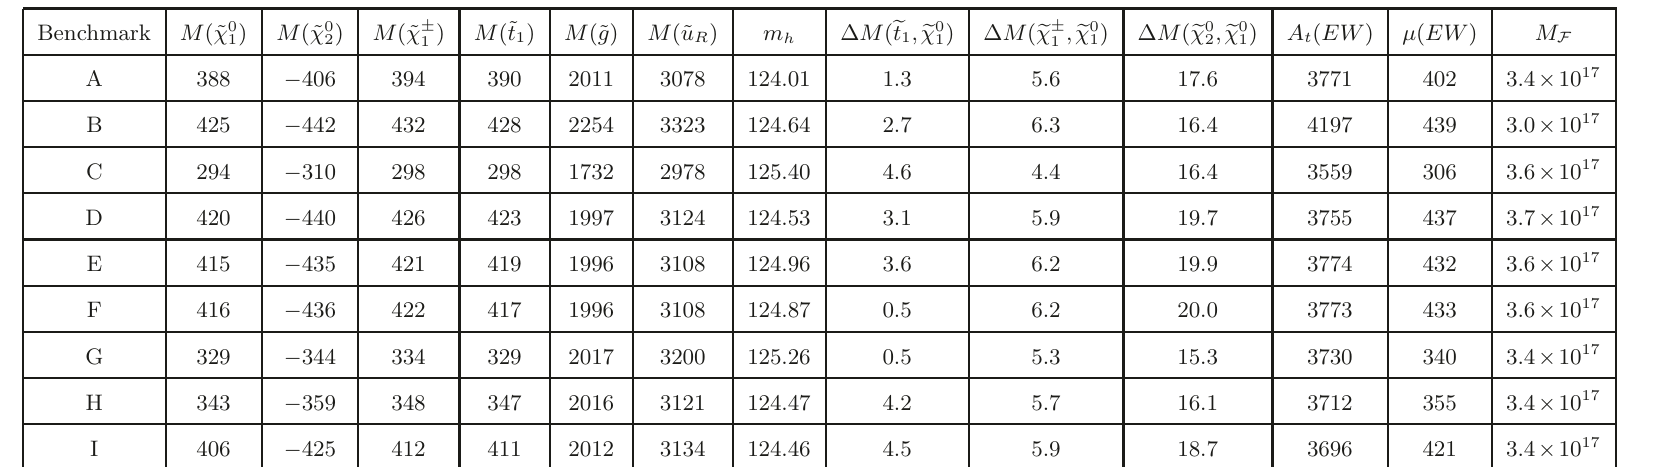
Table 2 . Relevant SUSY spectrum masses for the SUSY breaking soft terms of table 1 for the The soft SUSY breaking terms that generate each of these spectra can be identified by the alphabetical label. The light Higgs boson mass m h column represents the theoretically computed value consisting of the 1-loop and 2-loop SUSY contributions plus the maximum vector-like flippon contribution. The ∆ M columns provide the mass difference between the two SUSY particles given. The M F value is the unification scale where α 1 X = α 5 . All values in this table are in